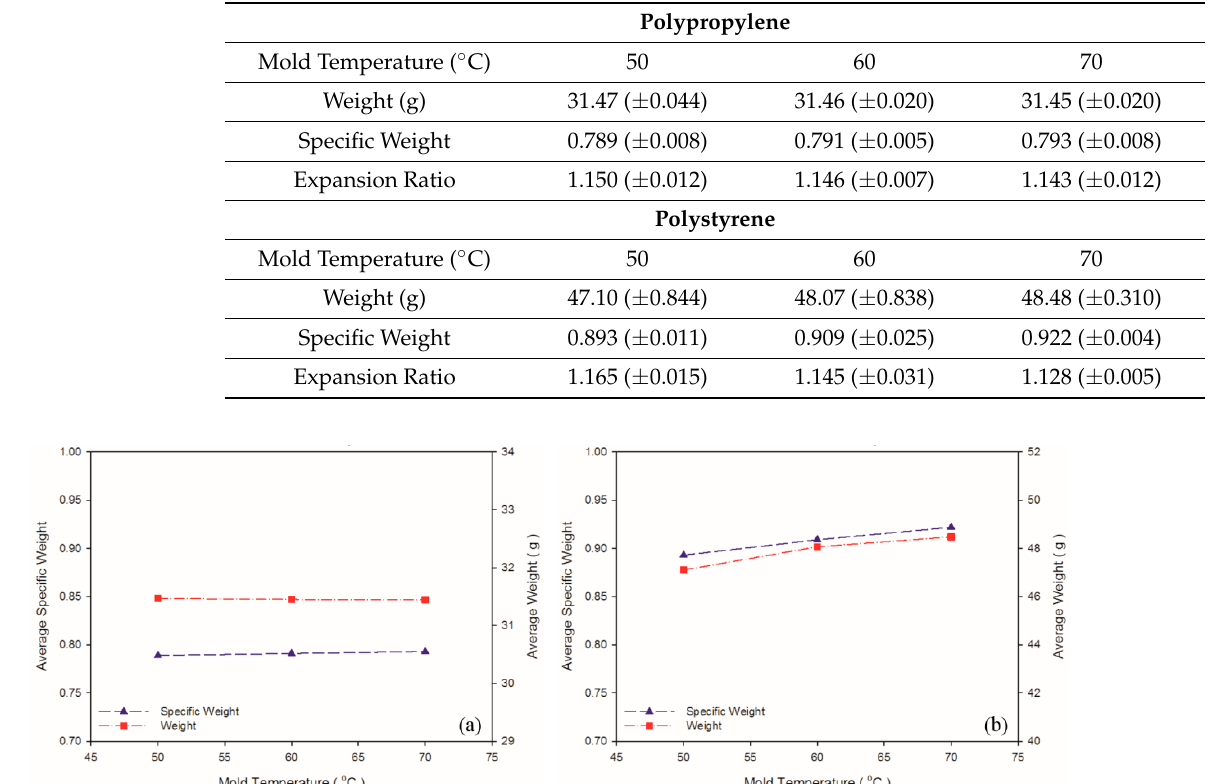
Table 8. Macroscopic effect of mold temperature on weight, specific weight, and expansion ratio.